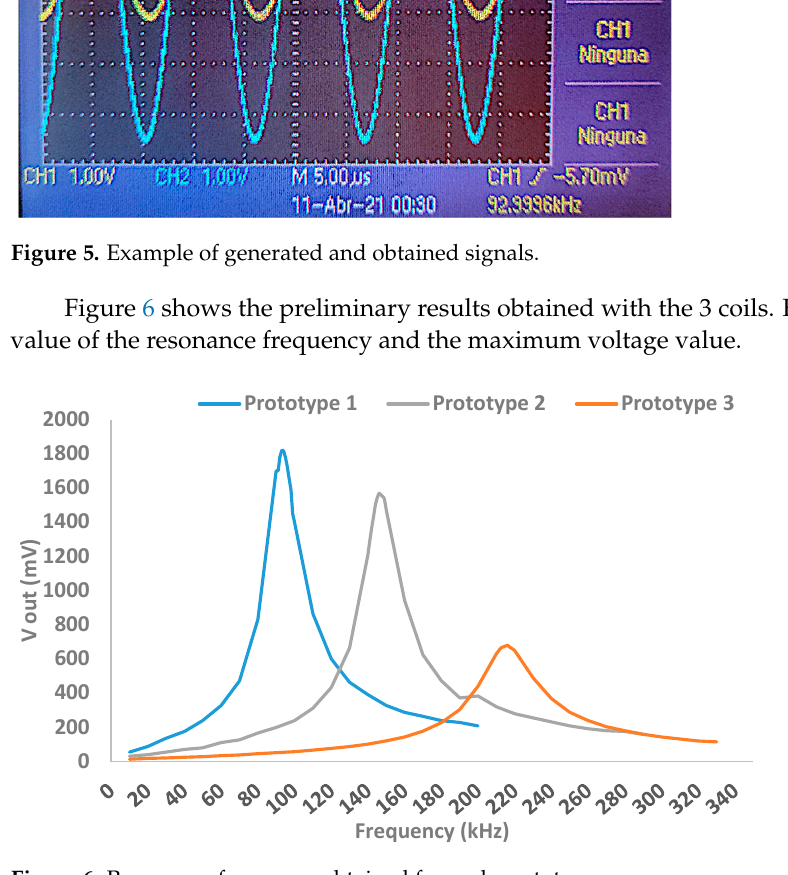
Table 4. Prototypes to measure soil moisture.